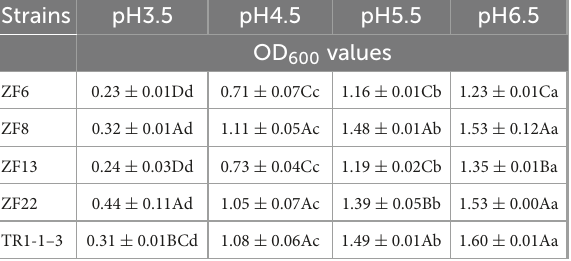
TABLE 2 Determination of the tolerance of lactic acid bacteria to different pH values.